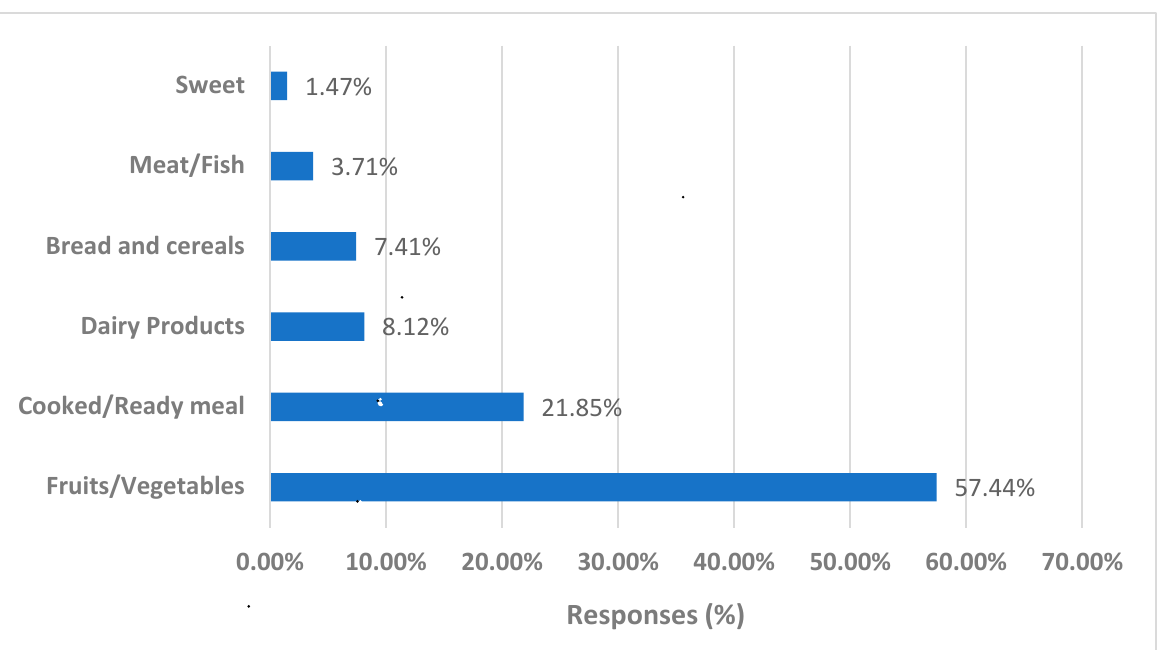
Table 3. Most usual household food waste in Greece based on consumers’ responses .